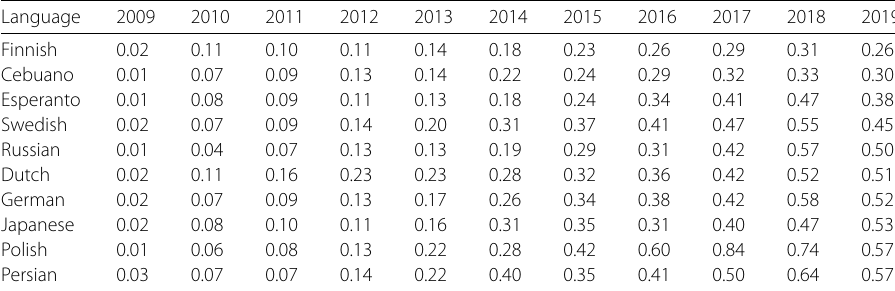
Table 3 Bottom 10 languages with the lowest annual average contagion ratio (sorted by 2019)